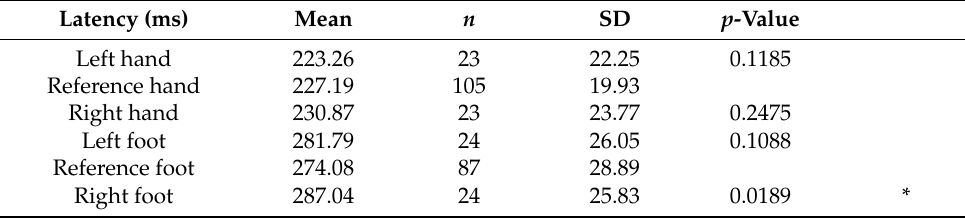
Table 3. LEP latencies in milliseconds for evoked potentials on left and right back of the hand or top of the foot. Reference material derived from in-house healthy subject normative data. * indicates a statistically significant differences to reference material with p -values corresponding to Bonferroni corrected